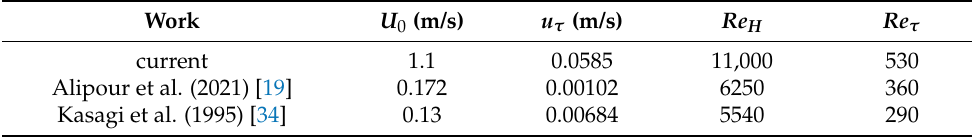
Table 1. Channel flow main characteristic